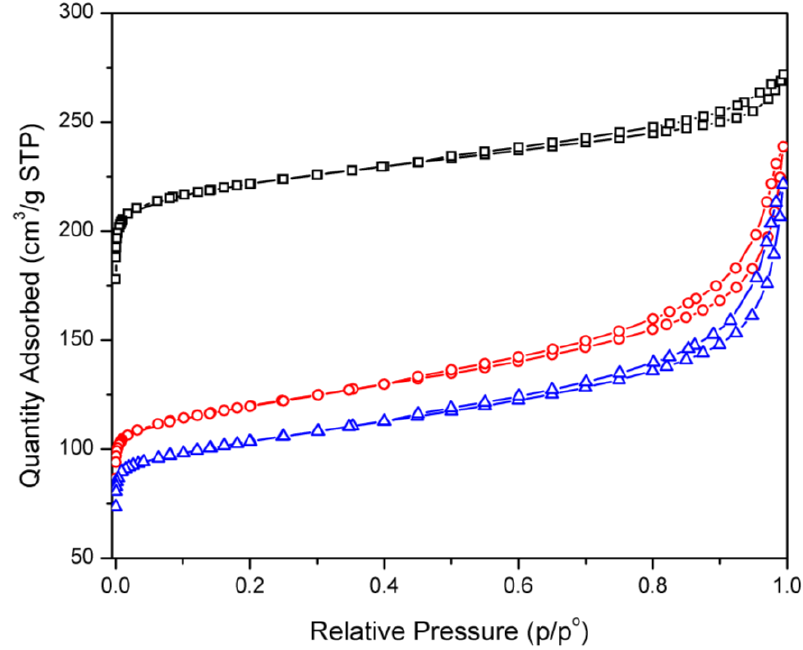
) Co/NaX, ( (cid:52) ) and (cid:35)